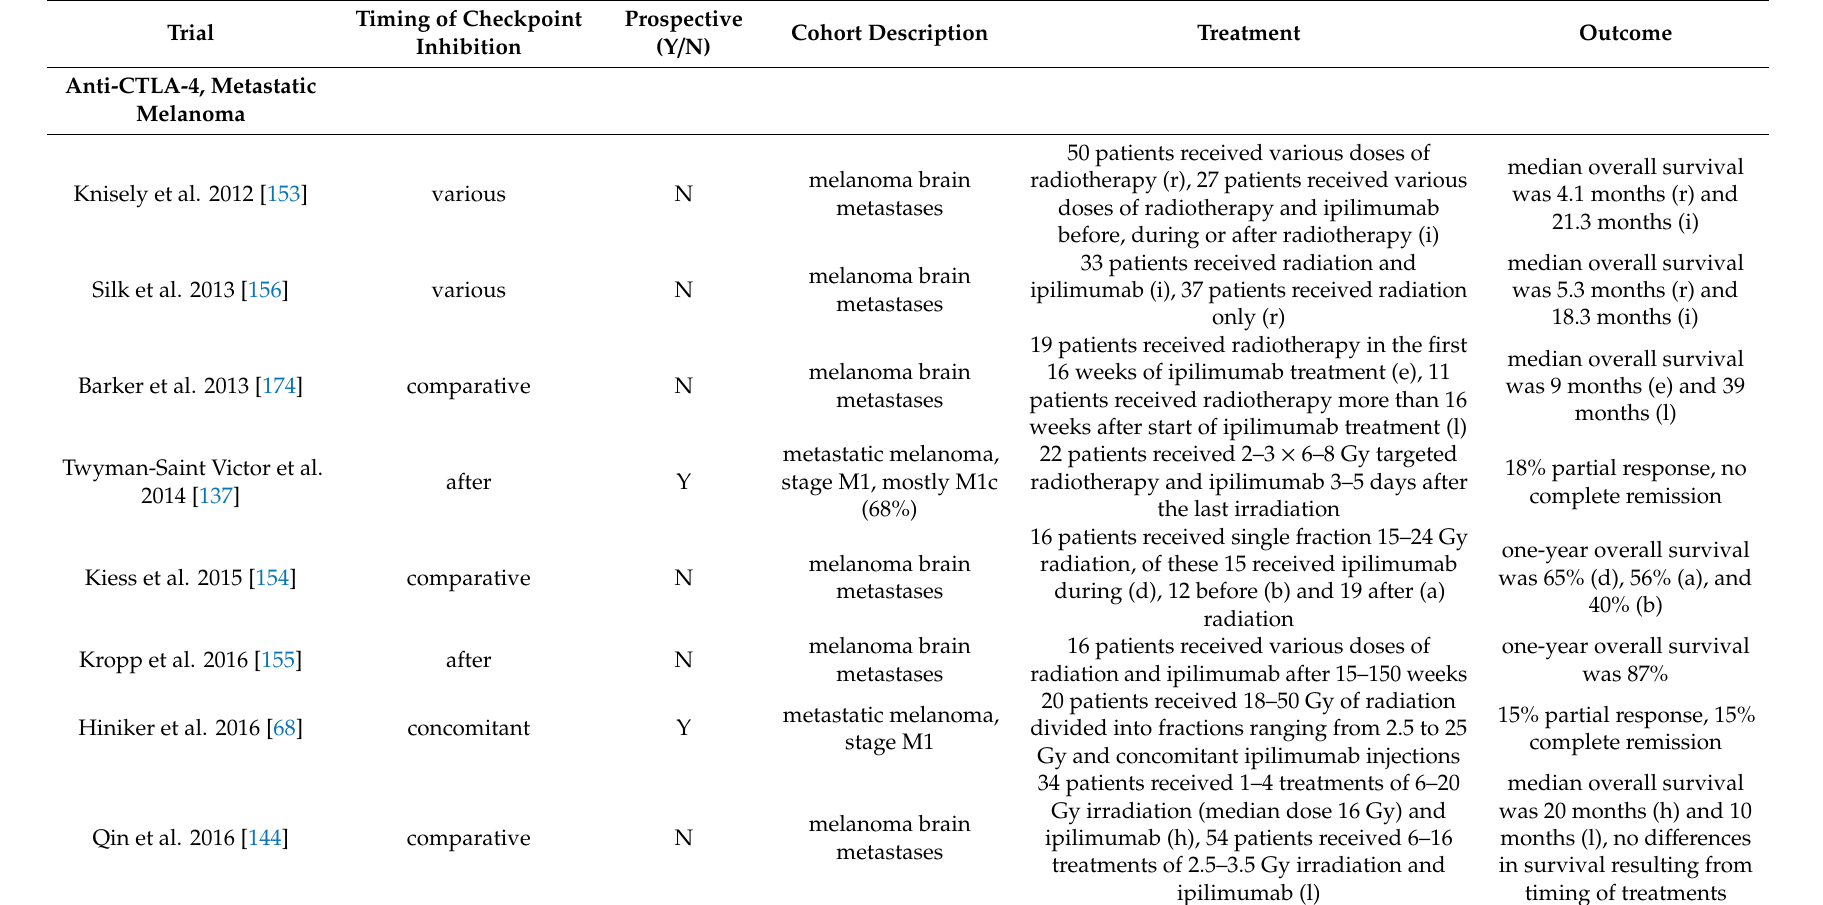
Table 1. Overview of clinical trials concerning combination of radiotherapy and cytotoxic T-lymphocyte-associated protein 4 (CTLA-4) blockade treatment in metastatic melanoma. Clinical trials are sorted primarily by cancer and treatment setting, secondary criteria being chronological. Short descriptions of patient collective, treatment, and outcome are